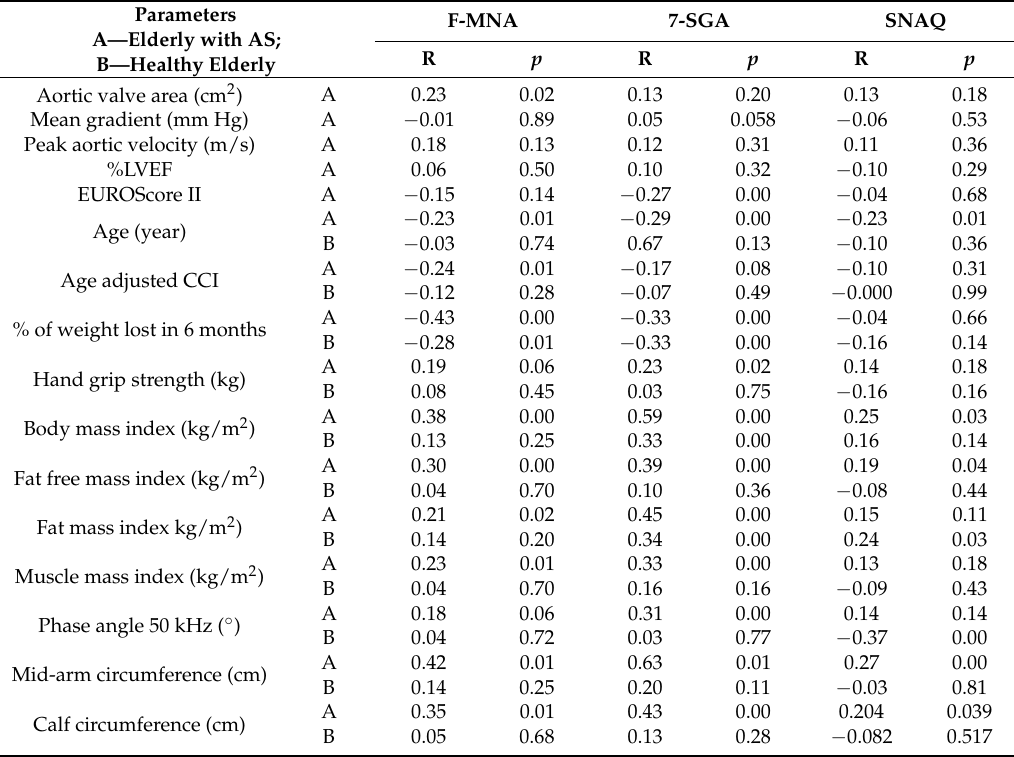
Table 6. Association between nutritional status, appetite, body composition and cardiac parameters. Parameters A—Elderly with